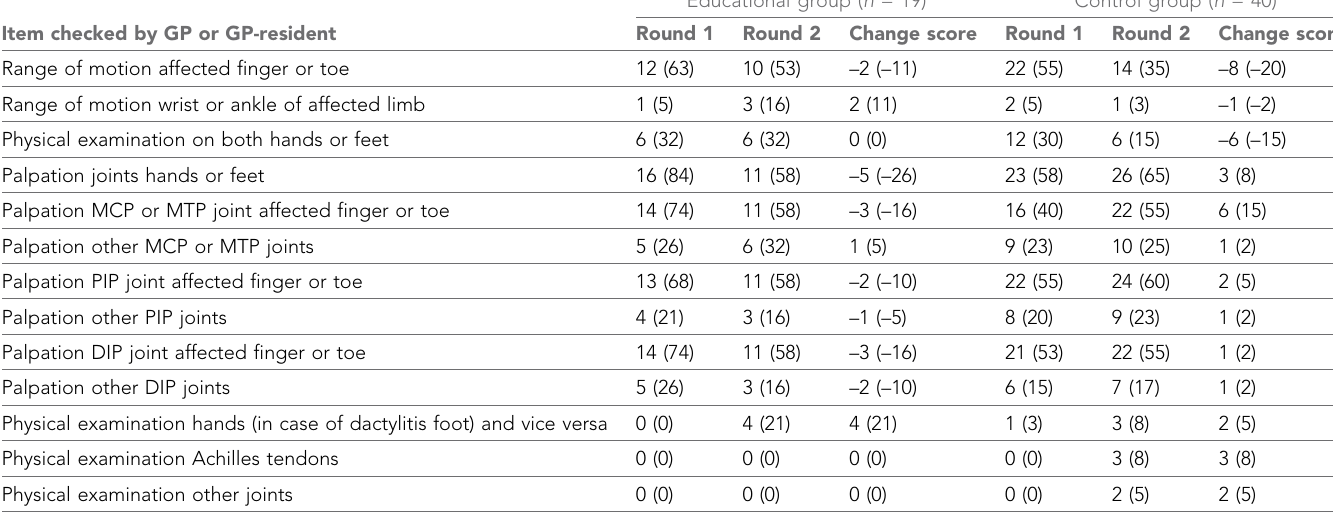
The values are expressed as number (percentage) of GP(-residents). Numbers may not add up due to rounding. MCP = metacarpophalangeal. MTP = metatarsophalangeal. PIP = proximal